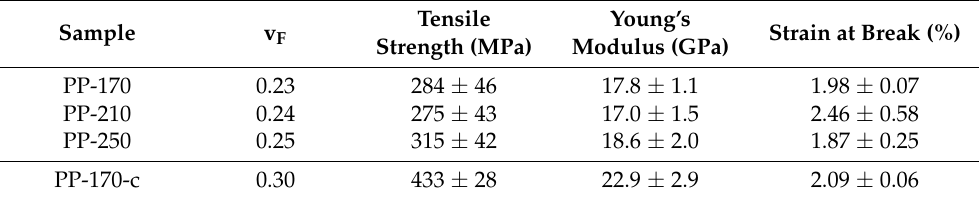
Figure 6. Similar degree of impregnation observed through optical microscope images of BF-PP composites processed at pre-consolidation temperatures of ( a ) 170 °C, ( b ) 210 °C, and ( c ) 250 °C, and ( d ) BF-MAPP composite processed at pre-consolidation temperature of 170 °C. Table 5. Tensile properties of the UD basalt fibre PP composites. Sample v